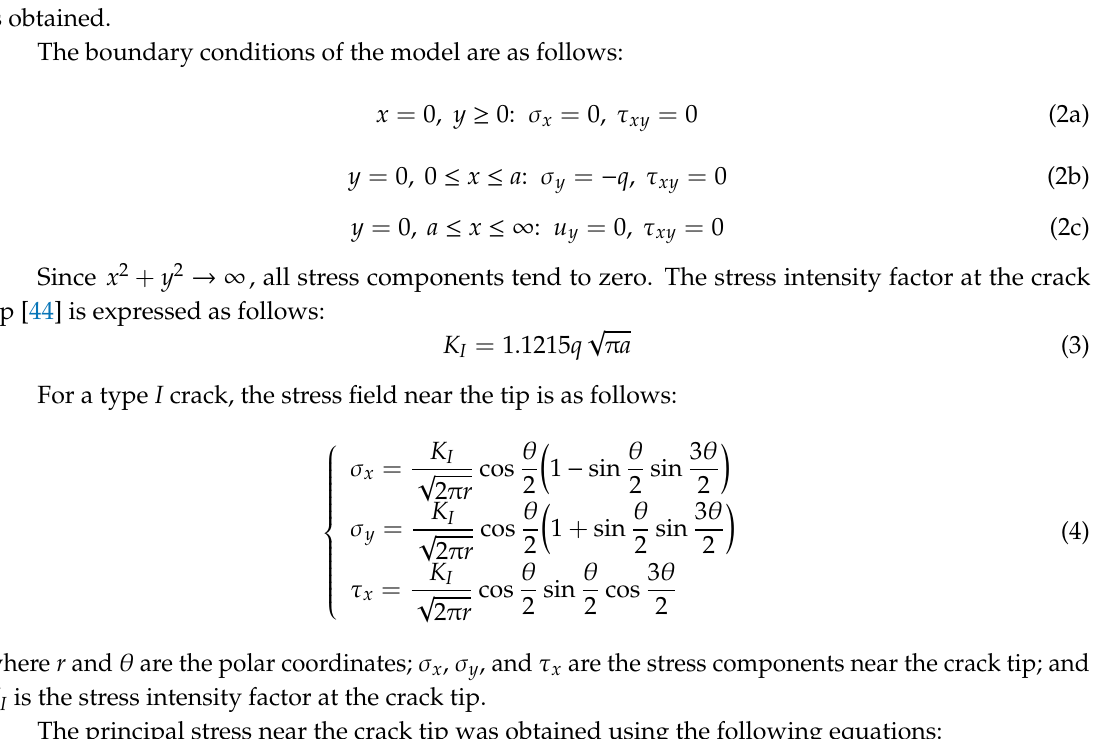
Figure 10. Frost-heave force model of crack.